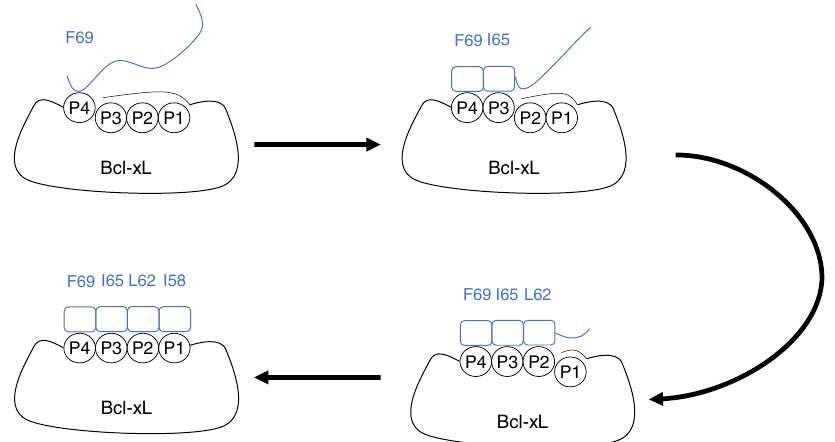
Fig. 6 Schematic overview of mutual induced- fi t binding between Bcl-xL (black) and Bim (blue). The cryptic pocket consists of Sites P1-P3, where these sites tend to be inaccessible without a ligand bound. As Bim binds, it folds into a helical conformation (indicated by the boxes) and causes the cryptic pocket to open up and the sites to become accessible, allowing Bim to also bind to these sites. Table 3 Overview of residues on the surface between Bcl-xL and Bim and their